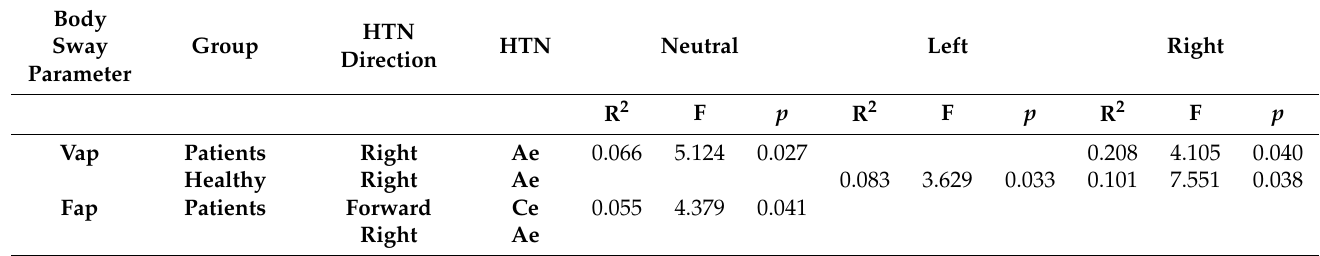
Table 3. Relations between body sway and head-to-neutral relocation test.